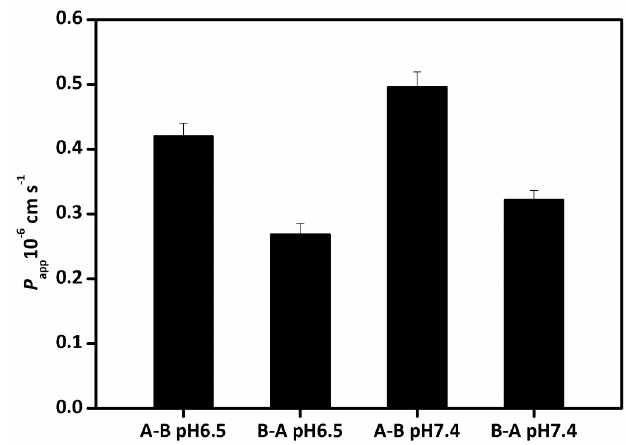
Figure 9. Transport of lipid-based nanoemulsions with Caco-2 cells monolayers Accumulation transport (A) and apparent permeability coefficient ( P app ) (B) during 4 h at 37 °C. (Mean droplet size is 170 nm). The data were expressed as mean ± standard with three independent replicates.